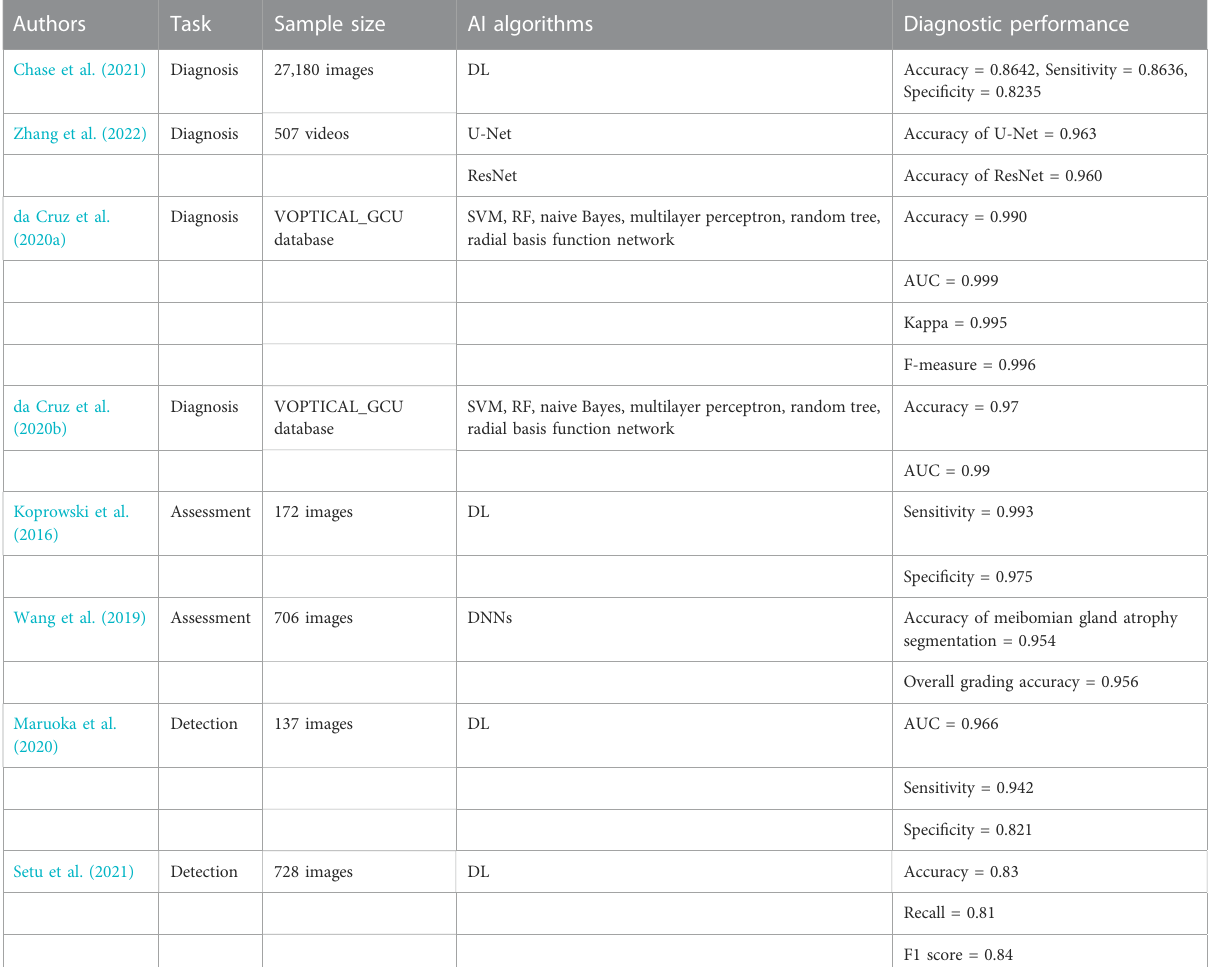
TABLE 3 Summary of application of AI models in dry